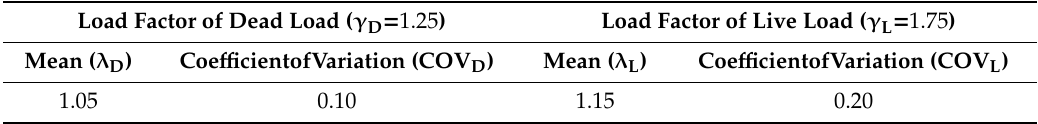
Table 5. Statistical characteristics of the loads.